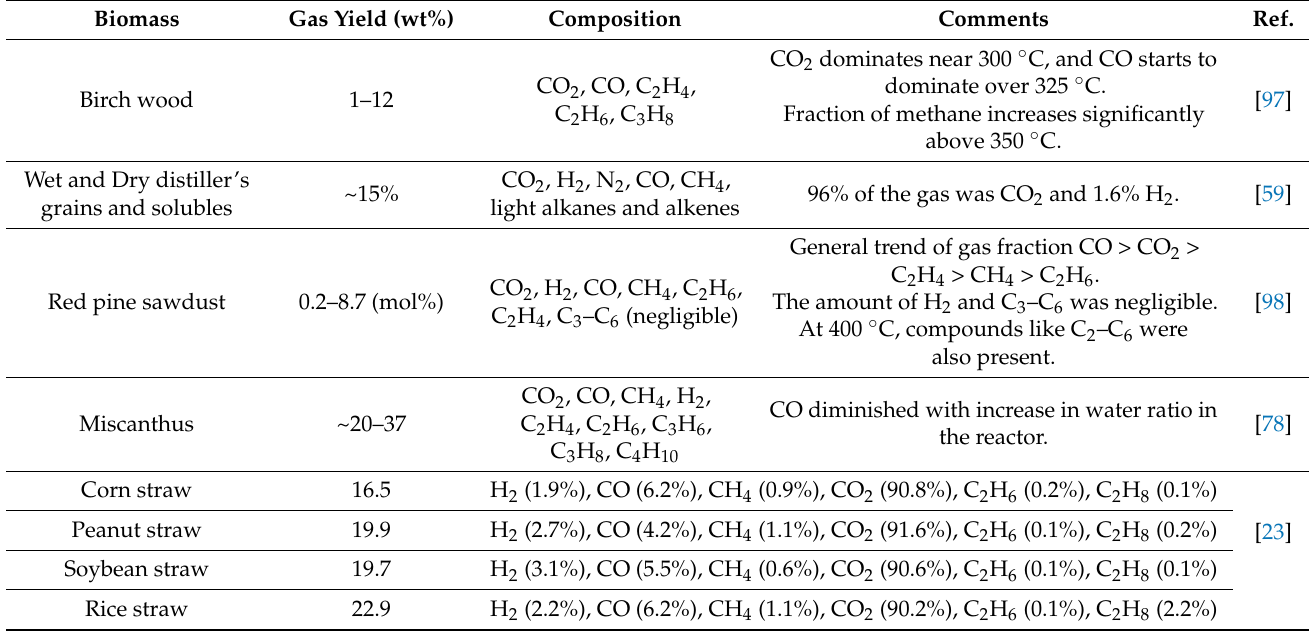
Table 14. Various gas compositions obtained from the HTL